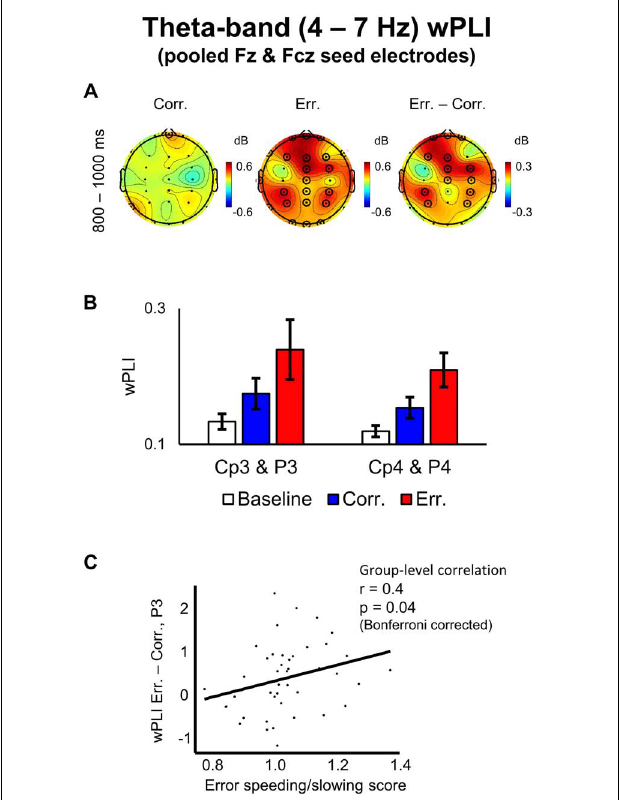
FIGURE 5 | Theta-band wPLI values with pooled Fz and Fcz seed electrodes and its correlation with error speeding/slowing score. (A) Topographical maps of baseline-corrected theta-band wPLI values with a seed of pooled electrodes Fz and Fcz at 800–1000 ms relative to response (left map represents correct responses, middle map – errors, and right map – difference: errors minus correct responses). Significant electrodes are highlighted with black circles ( p < 0.05, TFCE, permutation statistics). (B) Bar plots representing wPLI data at left posterior parietal electrodes (pooled Cp3 and P3) and at right posterior parietal electrodes (pooled Cp4 and P4), 800–1000 ms post-response time-window. Data are plotted as mean ± standard error of mean. (C) Differential theta-band wPLI values at P3 electrode vs. error speeding/slowing score (RT on erroneous trials divided by RT on correct trials). A regression line is